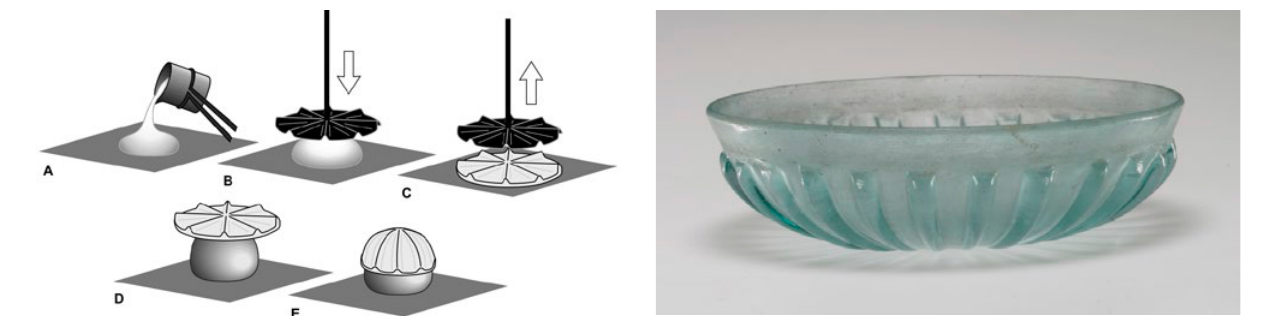
Figure 6. The formation of open-form bowls by sagging glass over convex “former” molds: (A) molten glass is poured onto a flat sur- face; (B) pressed with a flat, disc-shaped former; (C) cooled to cre- ate a glass disc; (D) transferred onto a “former” mold; (E) heated to cause the disc to sag over the mold giving the final bowl shape [adapted from reference 42 with permission from Springer Nature].